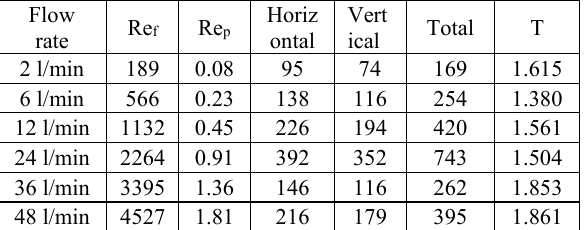
Table 2. Results of the measurement and statistical analysis in the simple straight tube.